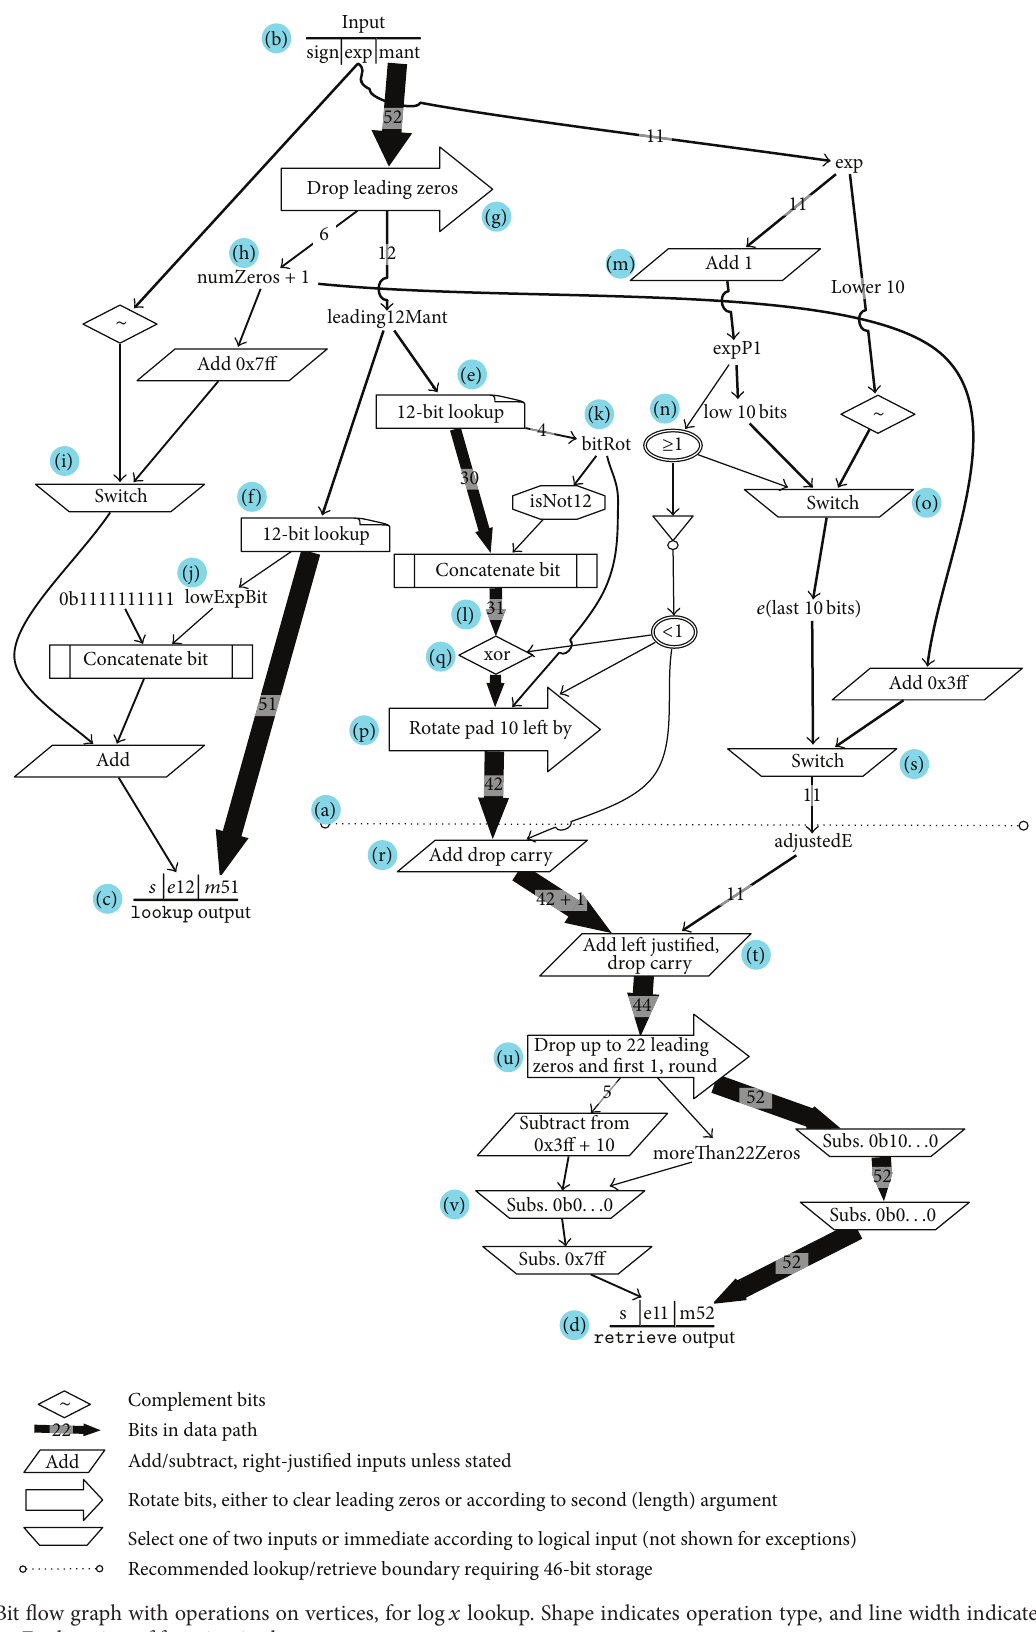
Figure 2: Bit flow graph with operations on vertices, for log 𝑥 lookup. Shape indicates operation type, and line width indicates data paths width in bits. Explanation of function in the